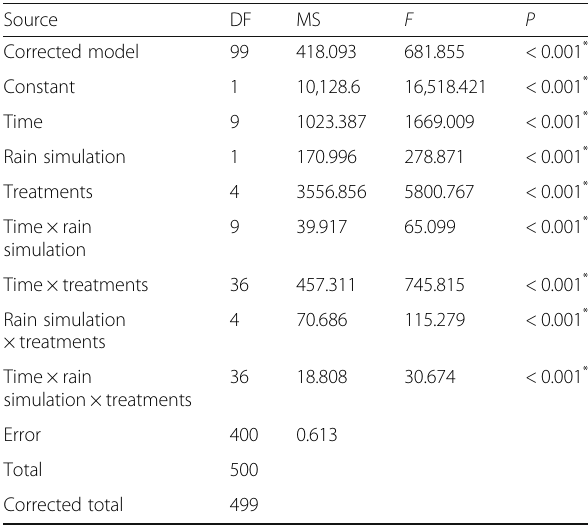
Table 2 Data on analysis of variance comparison of greenhouse experiments